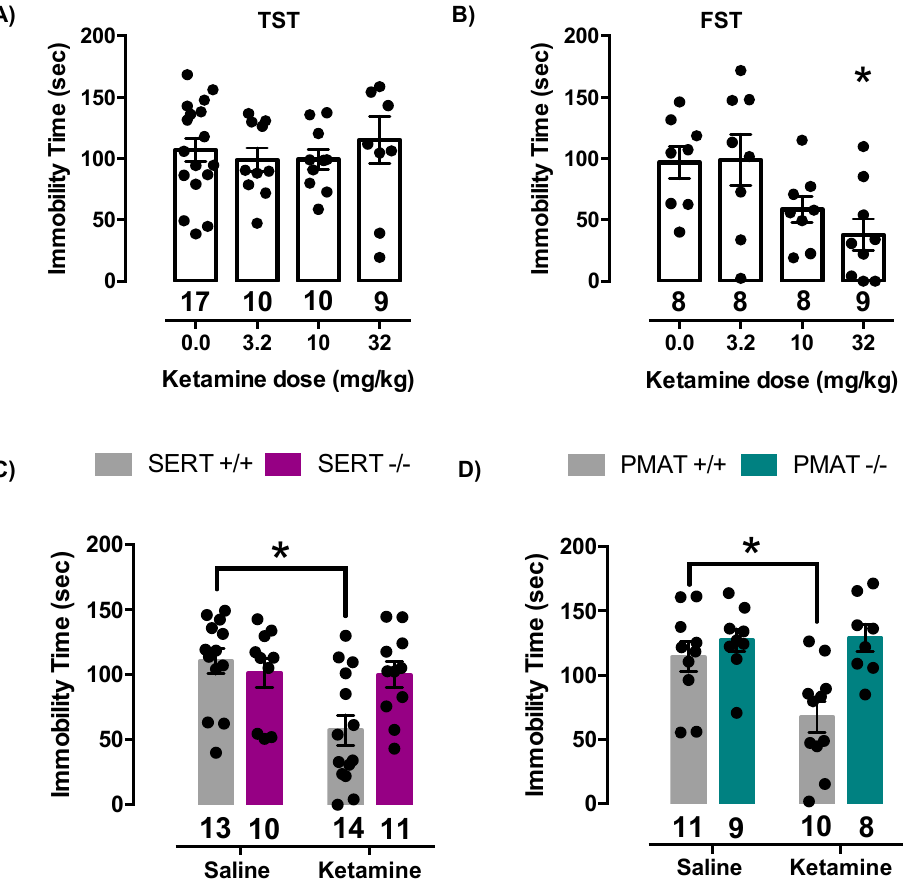
Figure 5. Ketamine lacks antidepressant-like effects in constitutive SERT or PMAT knockout mice. ( A ) Immobility time (s) in the tail suspension test and ( B ) Immobility time (s) in the forced swim test, in C57BL / 6 mice given ketamine (3.2, 10, or 32 mg / kg) or saline. * p < 0.05 represents 32.0 mg / kg ketamine significantly different from saline. Tukey’s post-hoc test for multiple comparisons. ( C ) Immobility time in the FST after 32.0 mg / kg ketamine or saline administered one hour prior to testing in SERT +/+ or SERT − / − mice. * p < 0.05 represents 32.0 mg / kg ketamine significantly different from saline; Tukey’s post-hoc test for multiple comparisons. ( D ) Immobility time in the FST after 32.0 mg / kg ketamine or saline administered one hour prior to testing in PMAT +/+ or PMAT − / − mice. * p < 0.05 represents 32.0 mg / kg ketamine significantly different from saline. Tukey’s post-hoc test for multiple comparisons. Circles represent individual mice. Data are mean ±